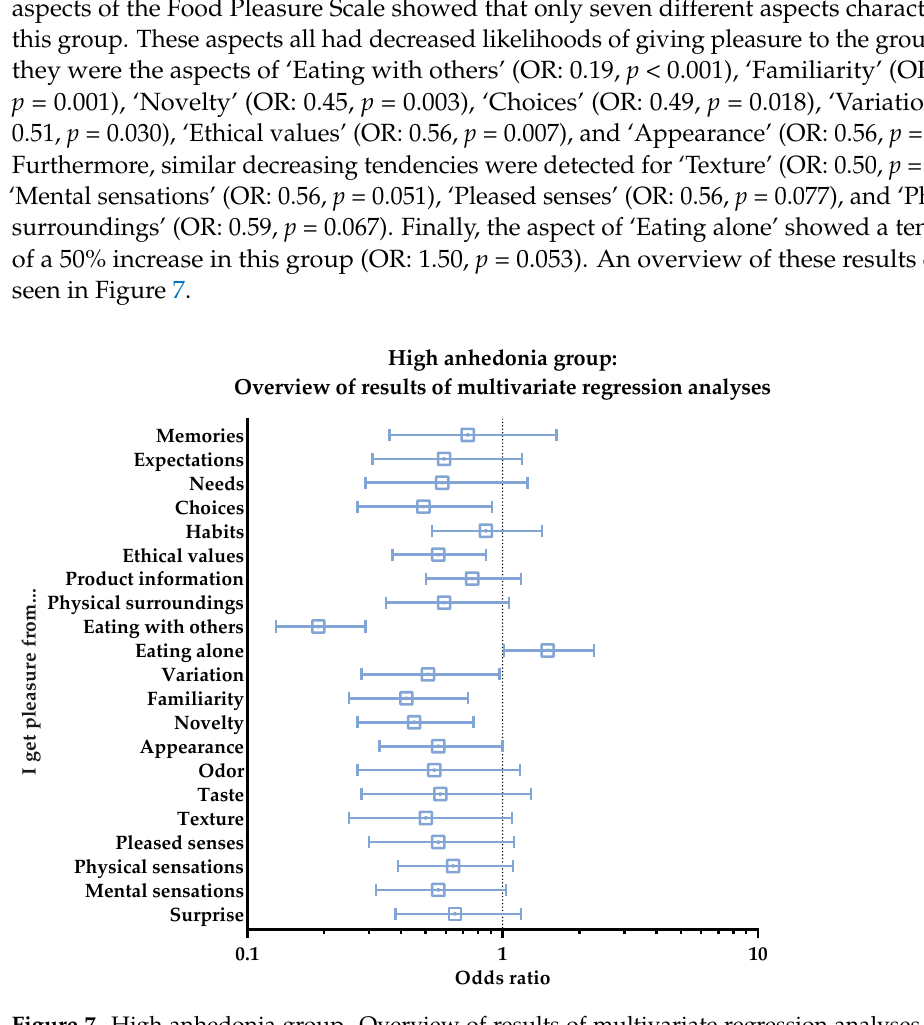
Figure 7. High anhedonia group. Overview of results of multivariate regression analyses for the subjective perception of the 21 different pleasure aspects of the Food Pleasure Scale. Results are shown as odds ratios, including interquartile ranges. An odds ratio > 1 indicates an increased likelihood of choice, whereas odds ratio < 1 indicates a decreased likelihood of choice.